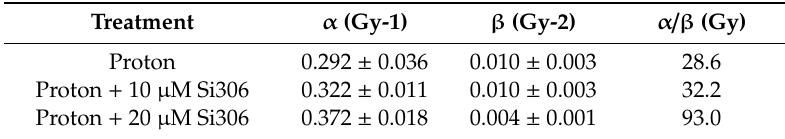
Table 4. Values of the α and β parameters estimated by fitting the cell survival to the linear-quadratic (LQ) model.